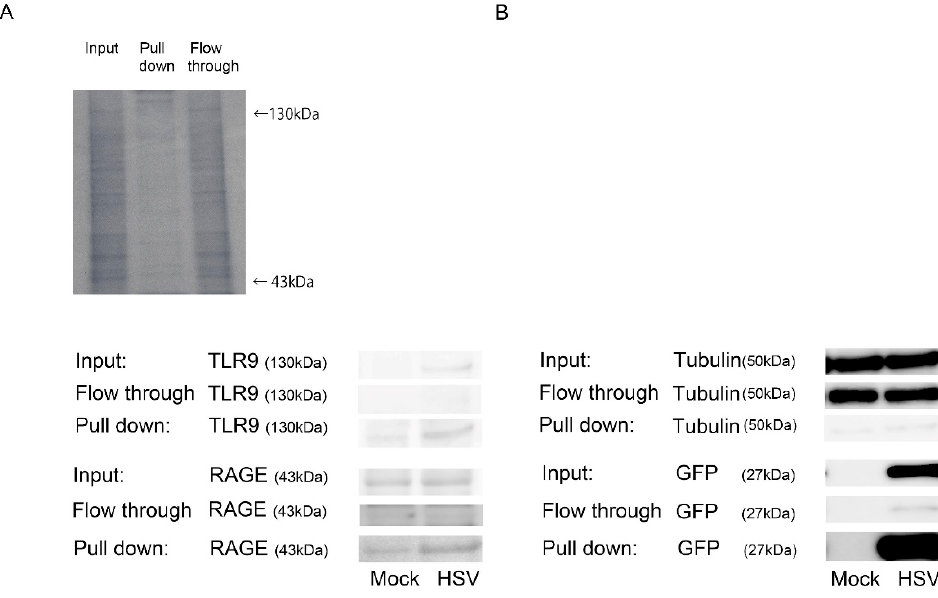
Figure 4. Association of TLR9, RAGE, and HSV-1. ( A ) Association of HSV-1 and RAGE by a GFP-pull-down assay. HCEn cells were infected with HSV-1 at MOI of 50, and the cell lysates as input were pulled down by anti-GFP antibody. The proteins associated with GFP-HSV-1 were detected by SDS PAGE. SDS PAGE, gel stained by Coomassie Blue, is shown as the input, pull down, and flow through fraction (upper panel). To observe RAGE and TLR9, Western blot for each fraction was conducted for RAGE and TLR9 (lower panel). ( B ) Tubulin and GFP in each fraction are shown by Western blot.